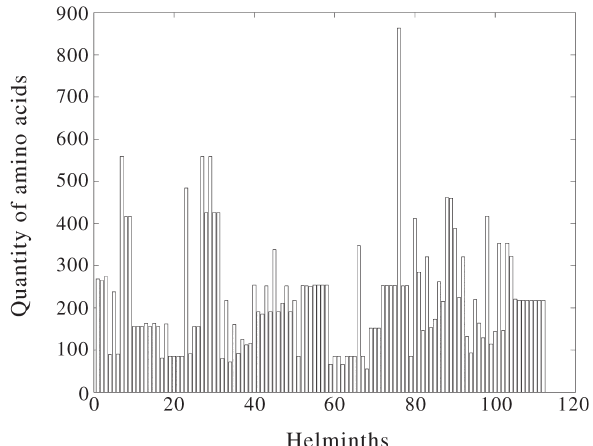
Figure 1 - Length of the analyzed antigens.